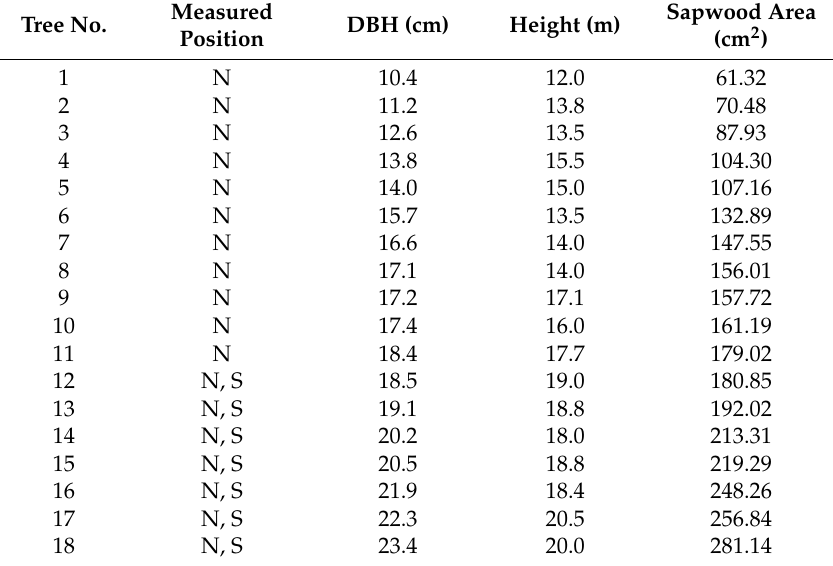
Table 1. Characteristics of the 18 sampled trees, and the number and aspects of sensors (N: North, S: South). Measured Tree No.